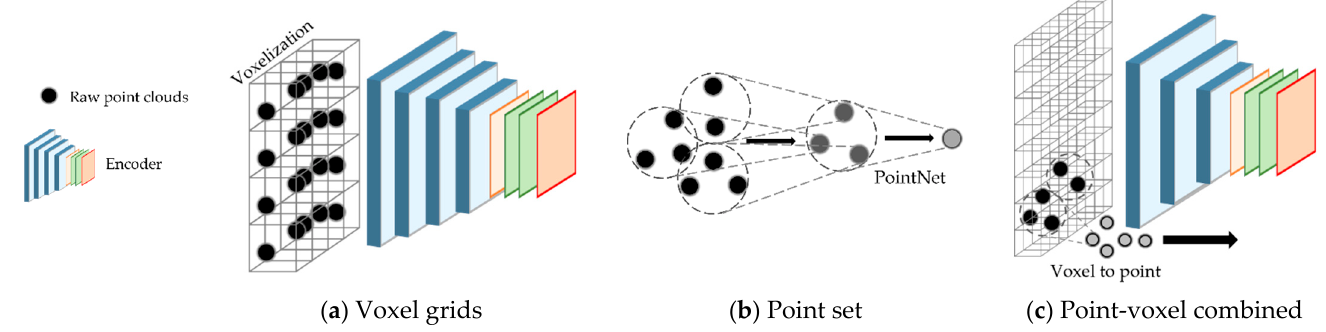
Figure 3. General classification of LiDAR-only detectors’ encoder [51].